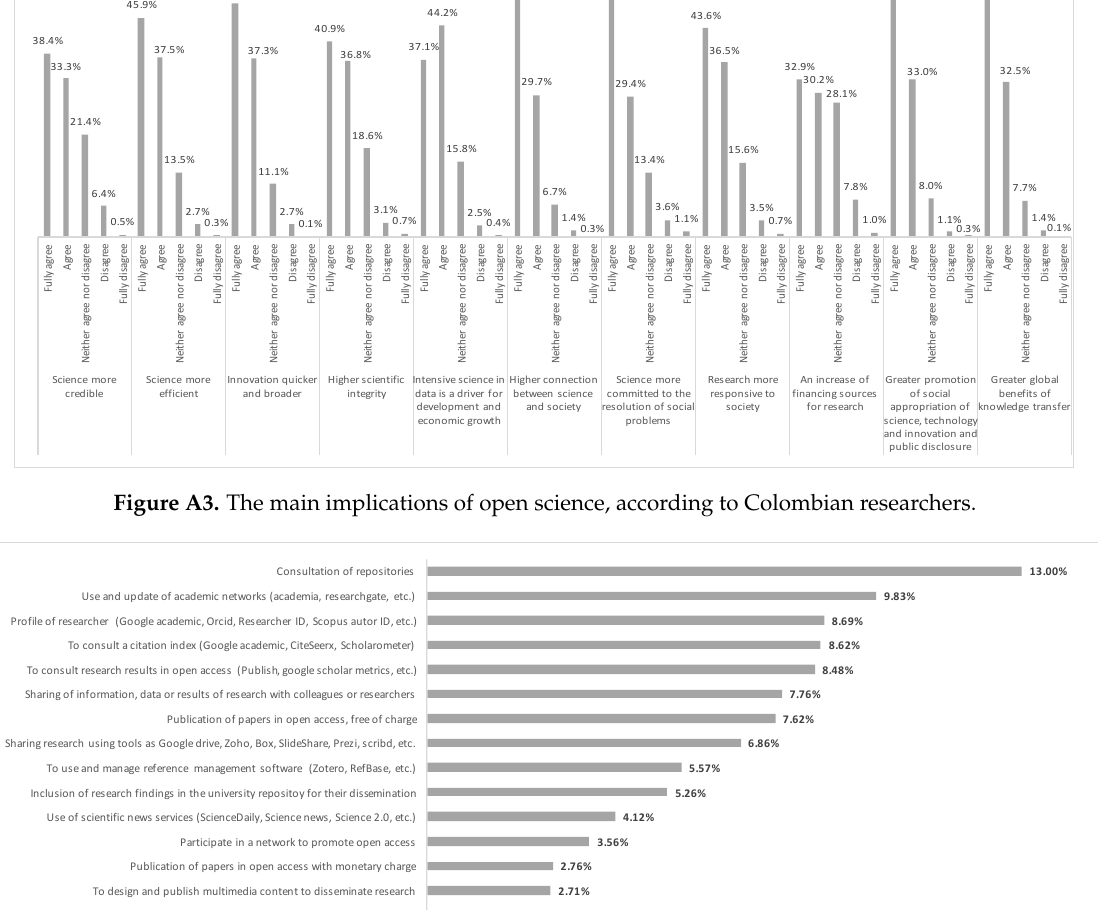
15 of 18 Figure A1. The main drivers of open science, according to Colombian researchers.